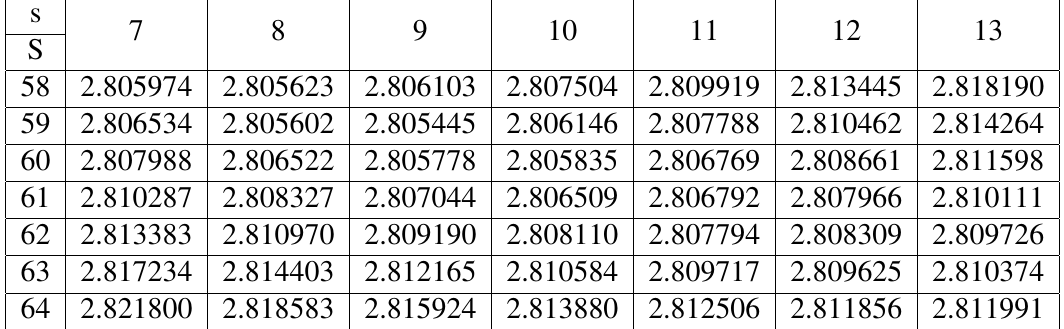
Table 1: TCV for the case of SDAP and